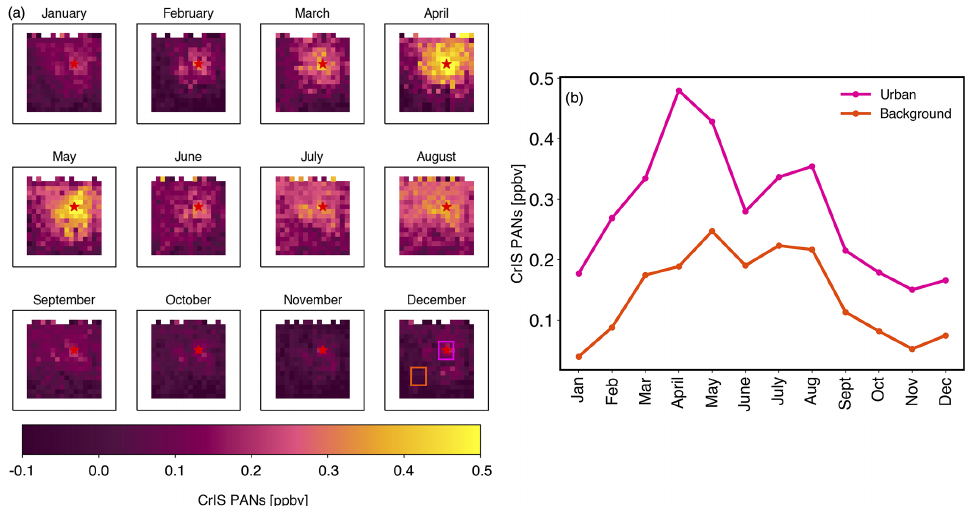
Figure 5. (a) Monthly mean gridded CrIS PANs over Mexico City. The boxes indicate the locations chosen to illustrate the urban Mexico City PANs (pink) enhancement compared to the “nearby background” (orange). The background box is confined by (18.99 ◦ N, 99.84 ◦ W, 18.49 ◦ N, 99.34 ◦ W) and the urban Mexico City box is confined by (19.15 ◦ N, 99.40 ◦ W, 19.65 ◦ N, 98.9 ◦ W). (b) Monthly mean urban and background mean CrIS free-tropospheric PANs for the period January 2016 to May 2021.